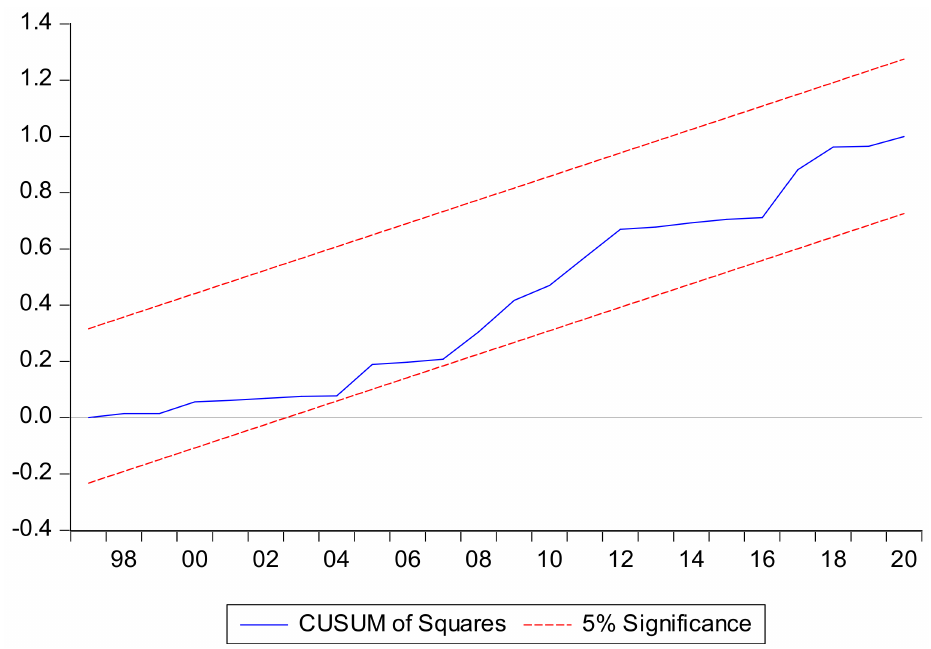
Figure 5. CUSUM of